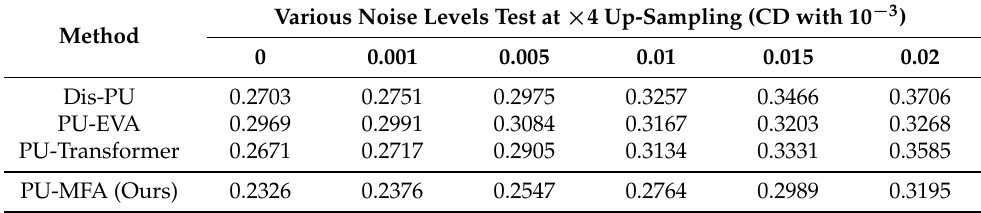
Table 5. Quantitative evaluation results of the noise effects using the PU-GAN